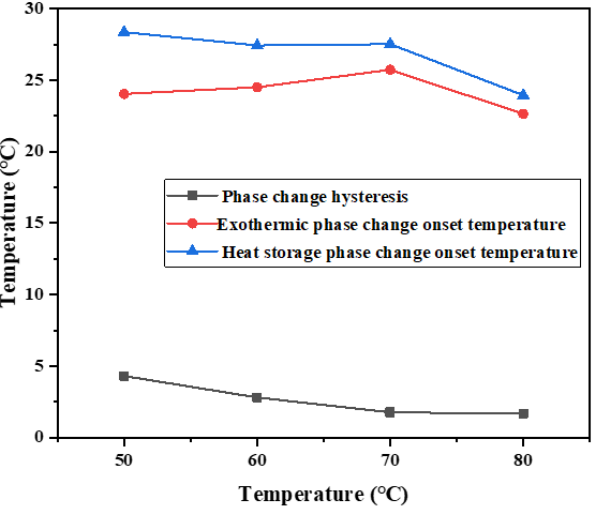
Figure 6. Influence of different heat storage temperatures on hysteresis characteristics of phase tran-